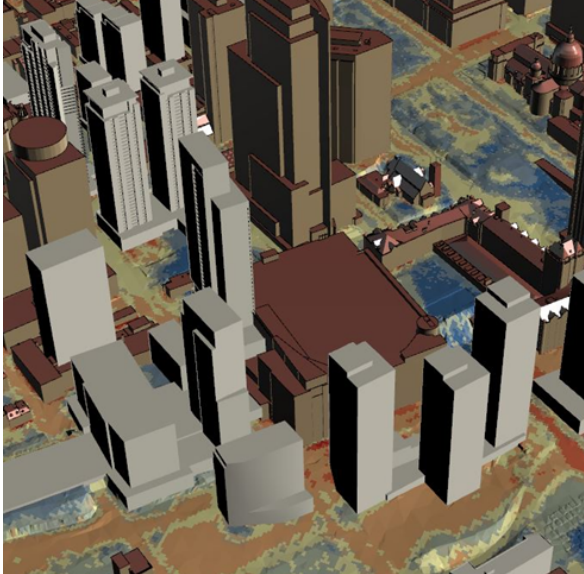
Figure 10. Quartier des gares project is an example where